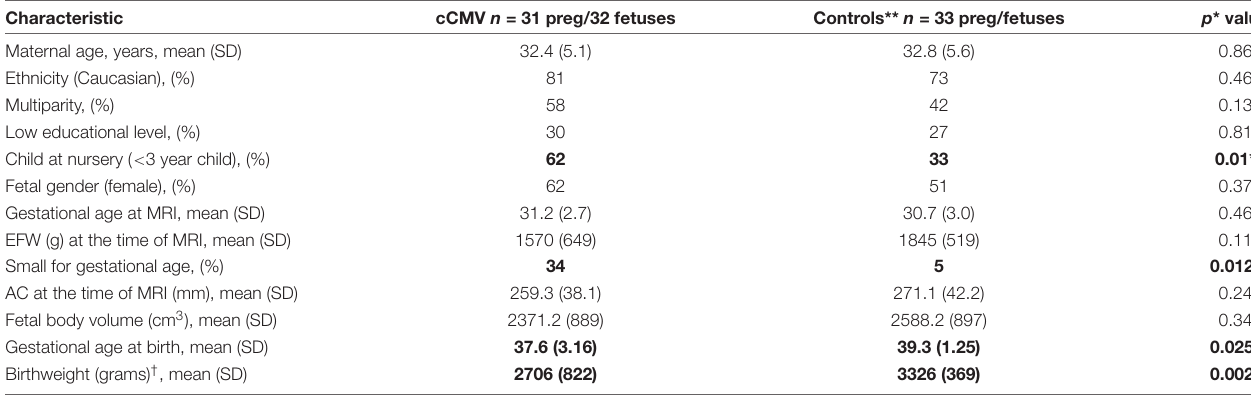
TABLE 1 | Baseline characteristics in pregnancies with and without congenital CMV infection. Characteristic